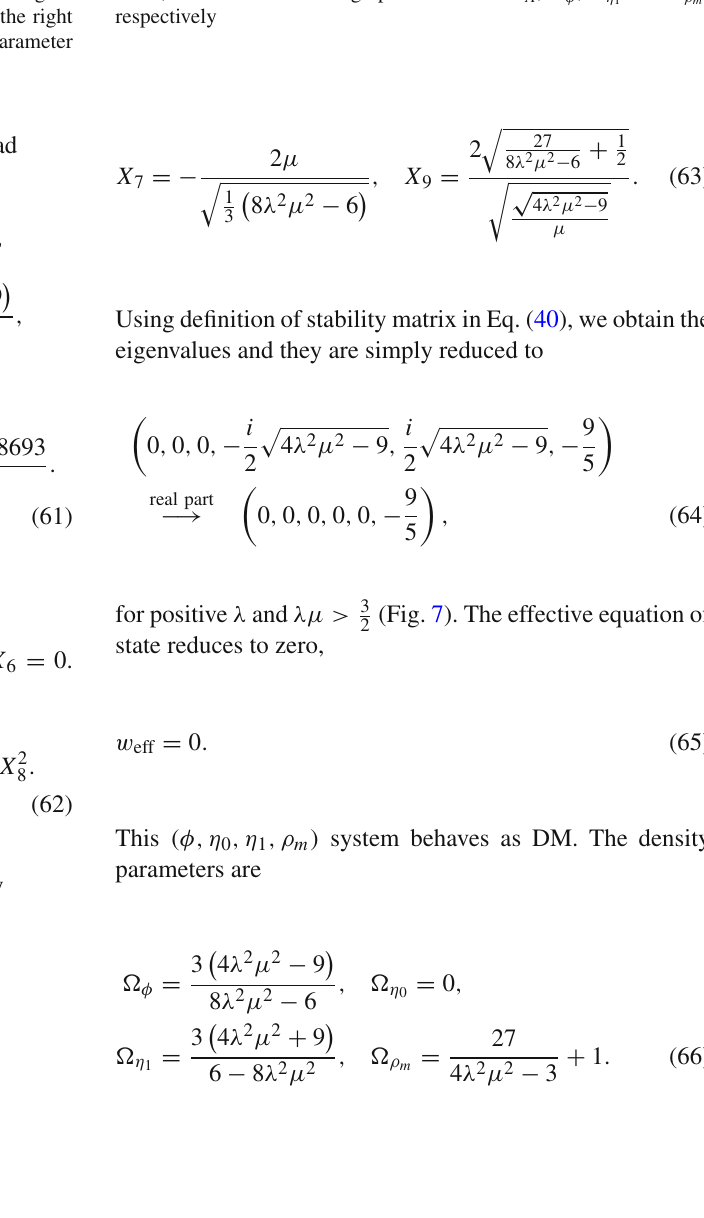
of non-vanishing fields and free parameters, i.e., λ and μ . The green, 3 black, blue and red line in graph b indicates (cid:12) A , (cid:12) φ , (cid:12) η